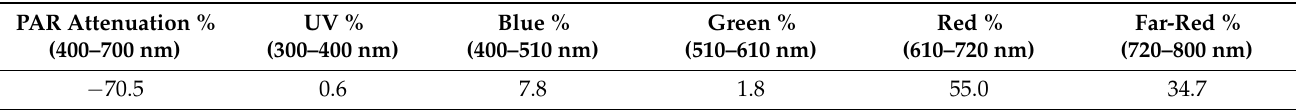
Table 2. Photosynthetically Active Radiation (PAR) attenuation and distribution (%) of transmitted radiation at different wavelengths through PolyMethylMethAcrylate (PMMA) ShieldUp ® doped with 160 ppm of Lumogen F305 luminescent dye. PAR Attenuation